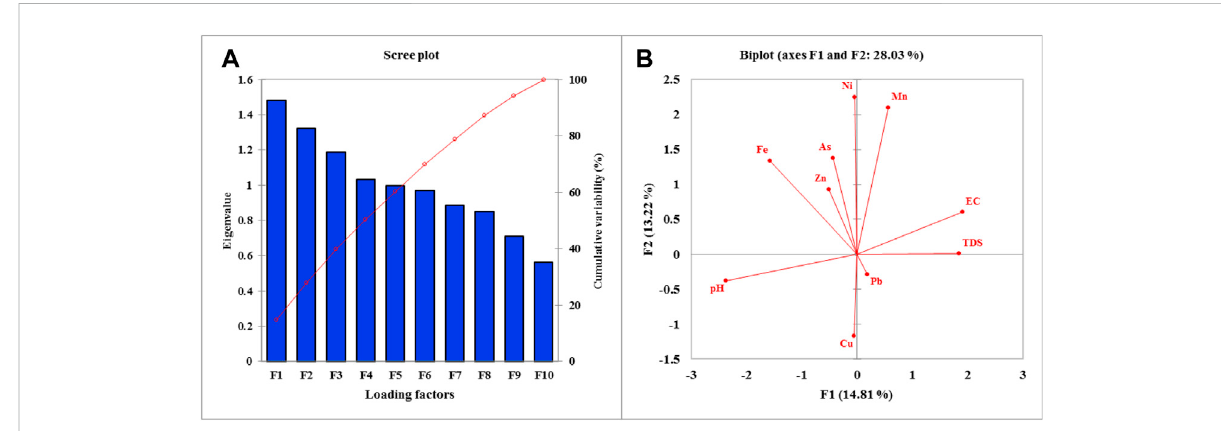
FIGURE 2 (A) Overall loading factors of PCA results, (B) Contribution of the fi rst two loading factors F1 and F2 after varimax